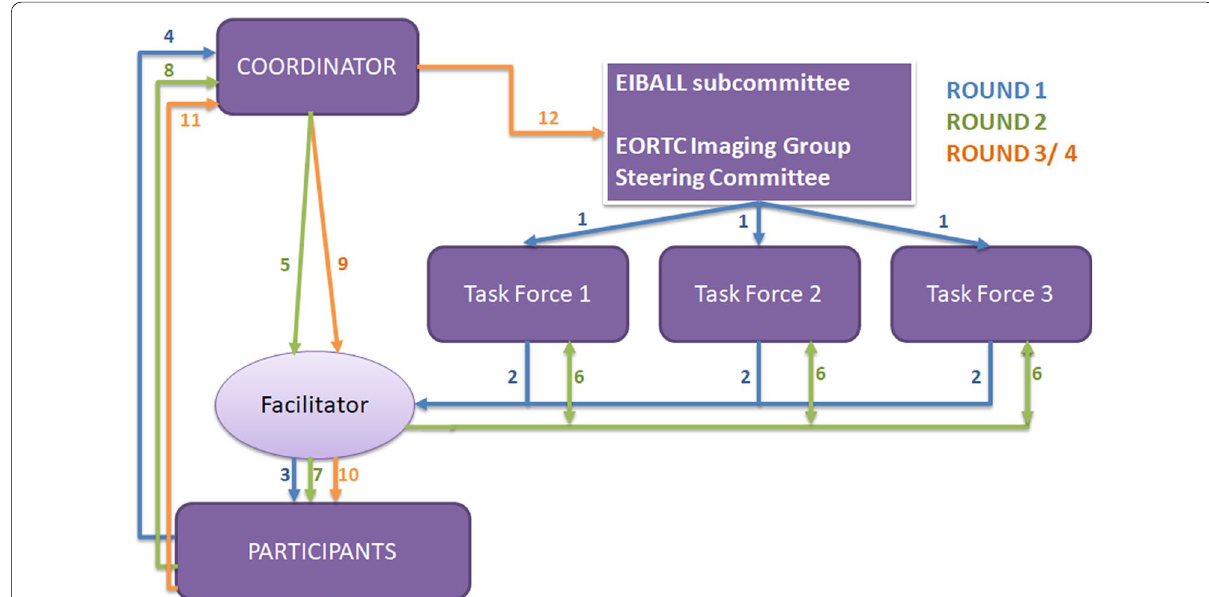
Fig. 1 Workflow for mDelphi process: The mDelphi process was initiated at the EIBALL and EORTC Imaging Group steering committee levels. In Round 1 (blue workflow), 3 task forces were assigned (step 1) to deal with (i) modality and image acquisition, (ii) segmentation methodology itself, and (iii) standards and logistical issues. The task forces formulated survey questions and submitted them to the facilitator (step 2) who then distributed them to the participants (step 3), with the results being fed to the co‑ordinator (step 4). In Round 2 (green workflow), the facilitator received (step 5) and amalgamated the responses and informed the task forces of the outcome so that they could devise a second round of questions and send them to the facilitator (step 6). These new questions were sent again to the participants of Round 1 (step 7) and responses collected by the coordinator (step 8). For Round 3 and iteratively for Round 4 (orange workflow), the responses received by the facilitator (step 9) were reviewed, and targeted questions were formulated towards achieving consensus and distributed again to participants (step 10). The final responses collected by the co‑ordinator (step 11) were circulated to the EIBALL and EORTC Imaging Group steering committees (step 12) for review and